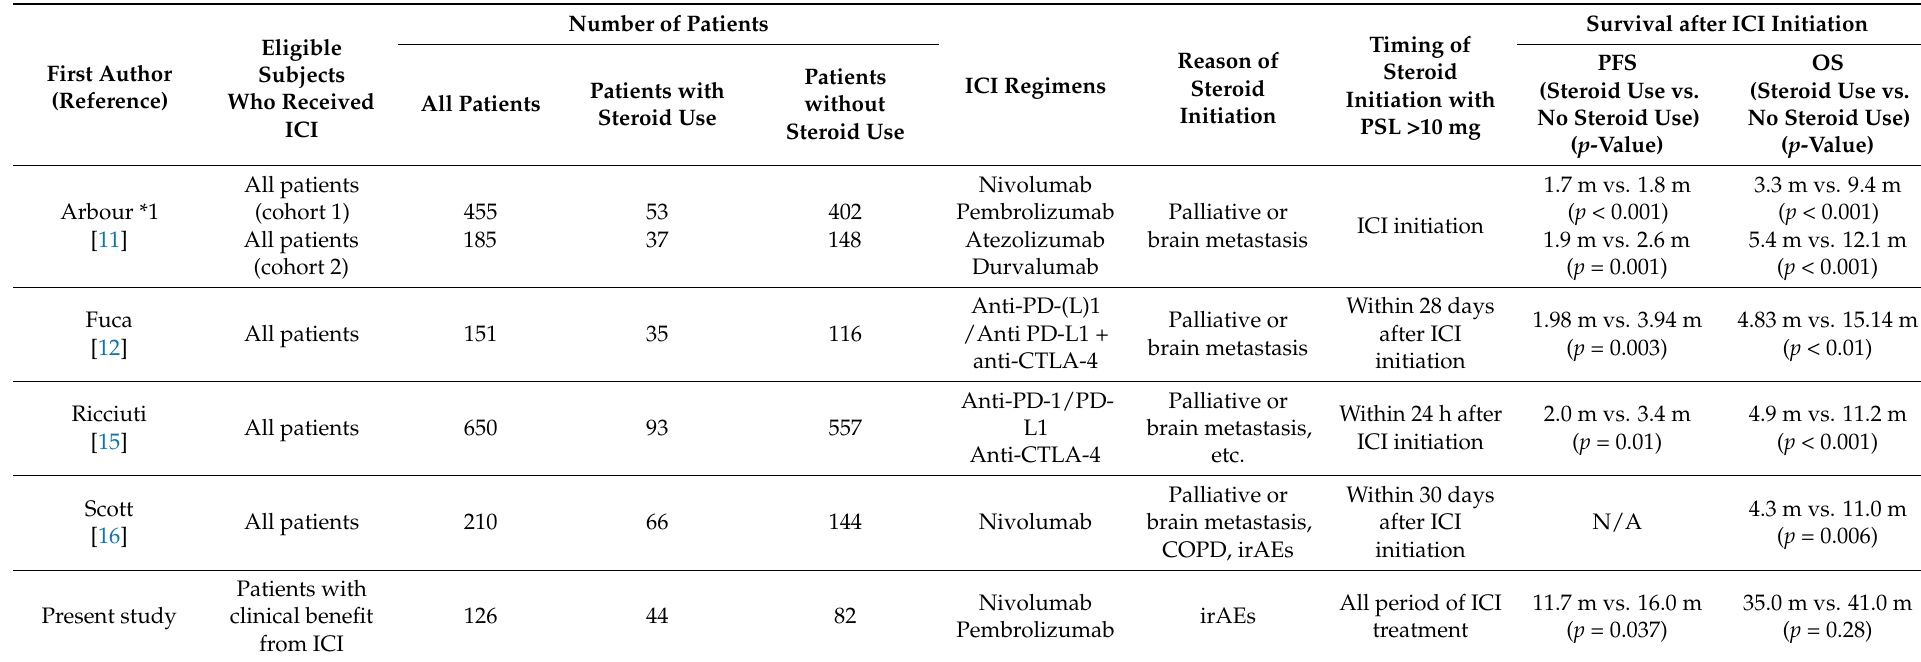
Table 4. Review of literatures reporting a relationship between systemic steroid use and ICI treatment in